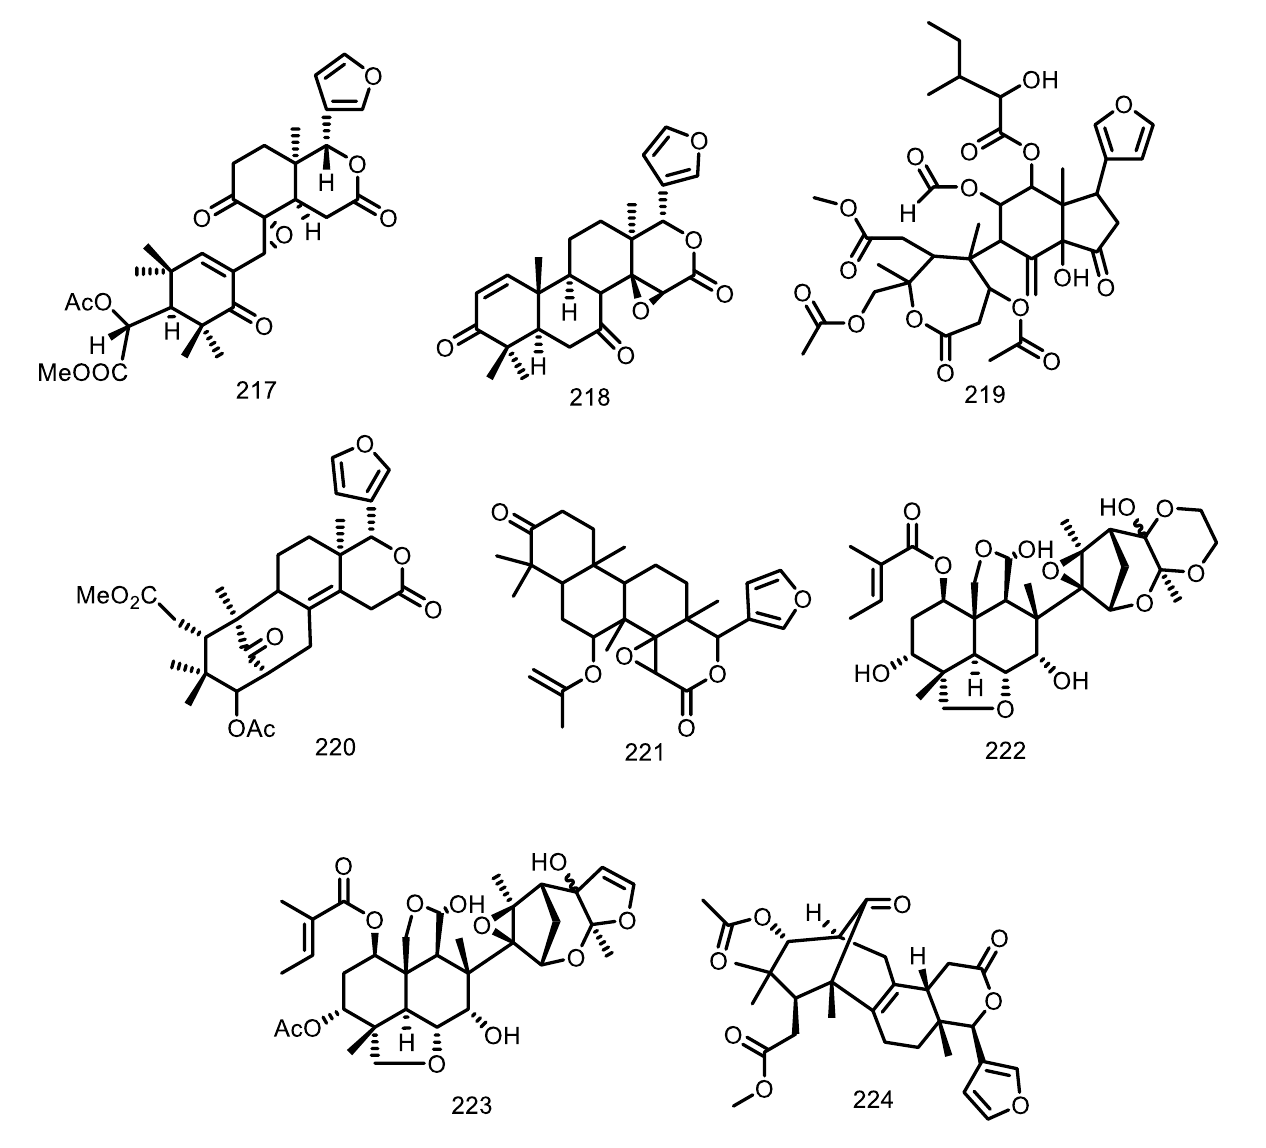
Figure 6. Limonoid from Guarea